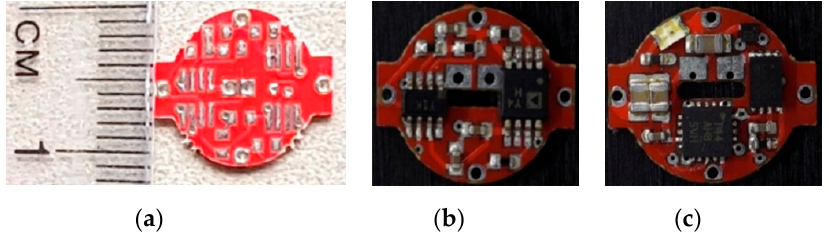
Figure 6. ( a ) Unassembled board. ( b ) Action potential detector (APD). ( c ) Optogenetic deep brain stimulator (ODBS).